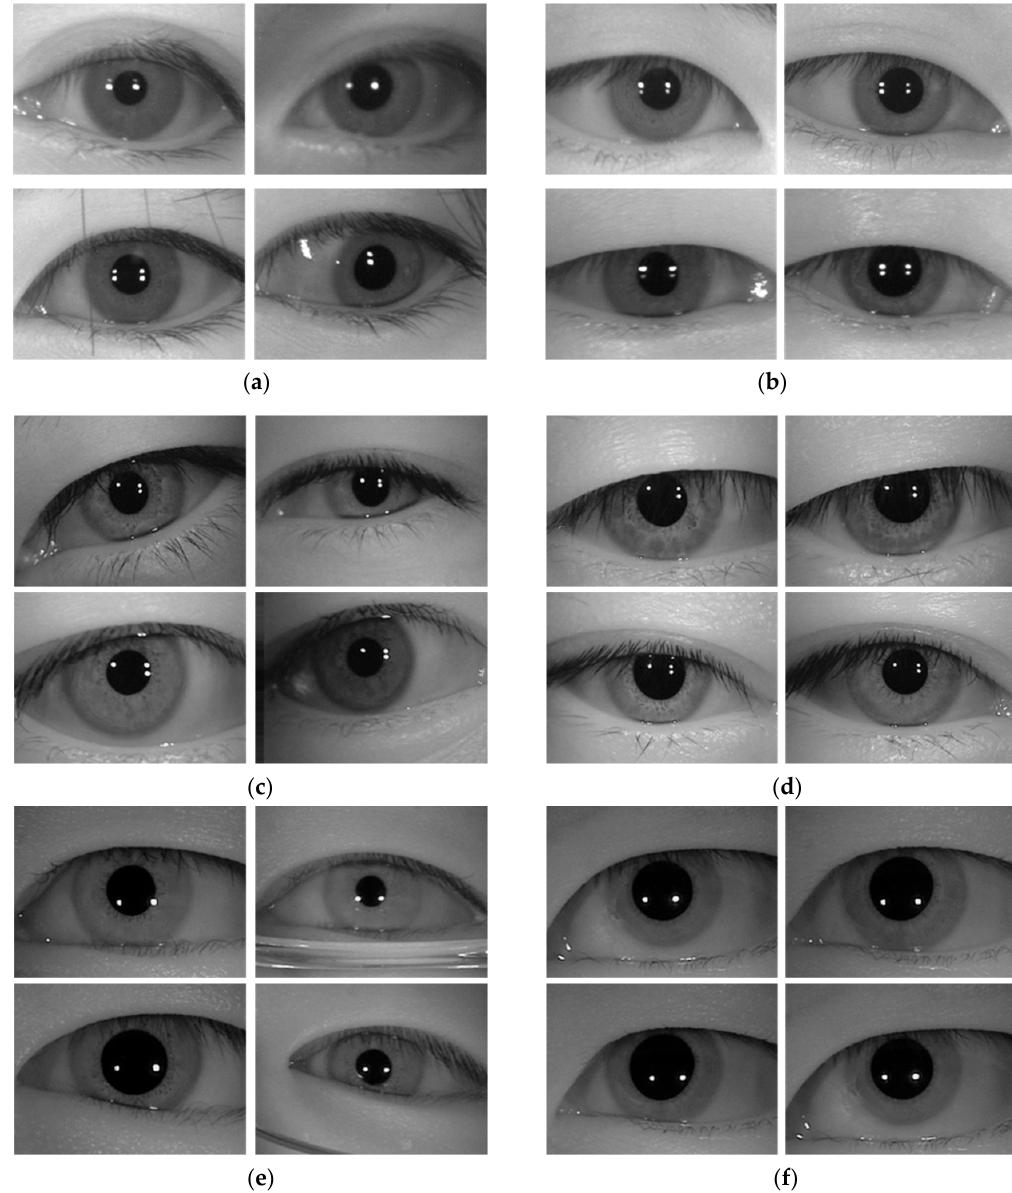
Figure 10 . Examples of recognition error cases due to the method proposed in this study. ( a , b ) CASIA-Iris-Distance database. ( c , d ) CASIA-Iris-Lamp database. ( e , f ) CASIA-Iris-Thousand database. ( a , c , e ) are FR cases. ( b , d , f ) are FA cases. In ( a – f ), the image on the left is the enrolled image, and the image on the right is the recognition attempt image.